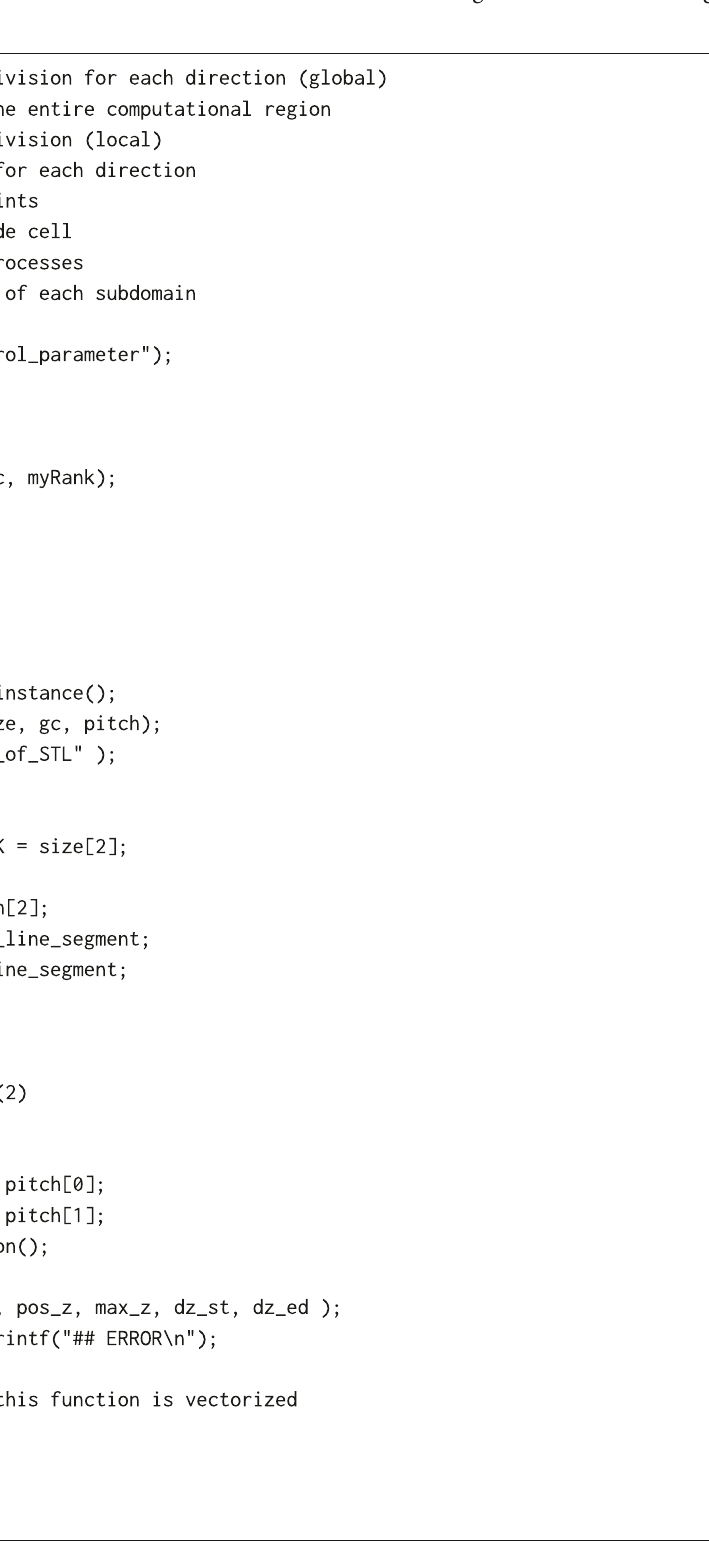
Figure 7: Pseudocode of the initialization phase of